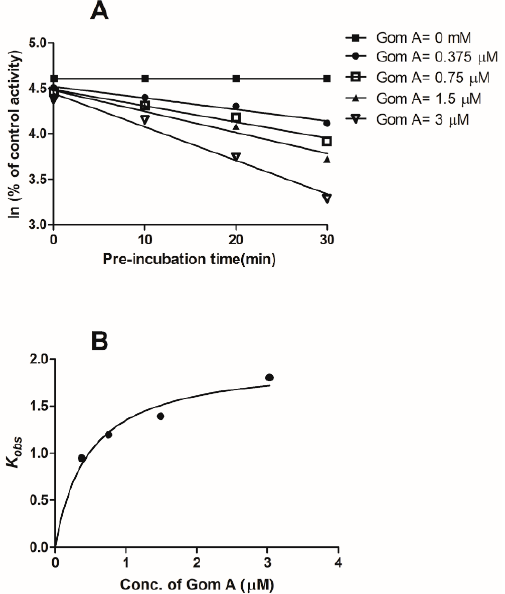
Figure 3. Inactivation of CYP3A4-catalyzed testosterone 6b-hydroxylase in human liver microsomes by Gom A. HLMs (0.5 mg protein/mL) were preincubated with 1% acetonitrile (vehicle control) or different concentrations of Gom A (0.375, 0.75, 1.5 and 3 µM) and NADPH-gs at 37 °C for 0, 10, 20 and 30 min in 100 mM PBS. ( A ) The plot of the percentage of control activity versus preincubation time; ( B ) The plot of the observed rates ( k obs ) versus different concentrations of Gom A, which was used to calculate the kinetic parameters K I and k inact . Each data point represents the mean of triplicate determinations.